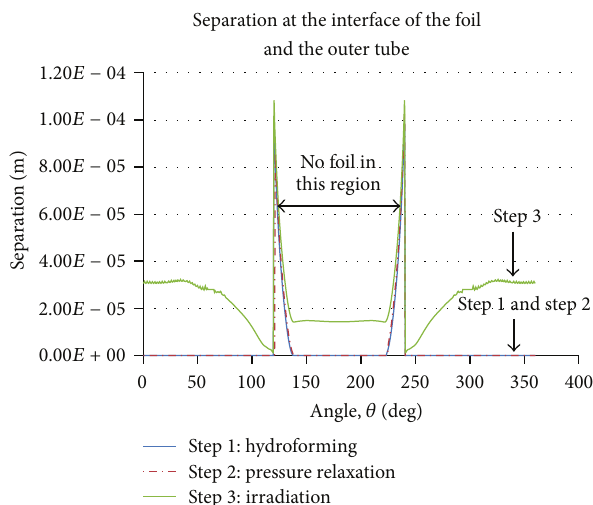
Figure 10: Separation at the interface of the foil and the outer tube after the various modeling steps.